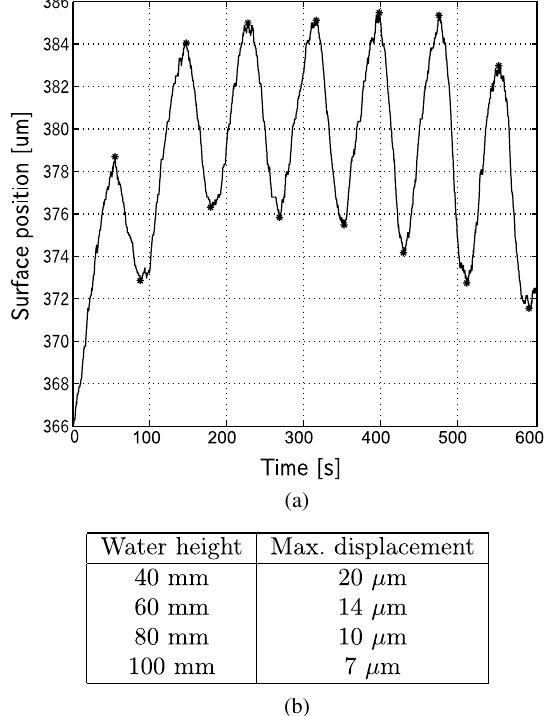
Fig. 3. (a) A time course of the surface displacement in the case of 100 mm water height. First 10 min is shown. (b) A table of the max- imum water displacement with different water height. It decreases monotonically as the water height